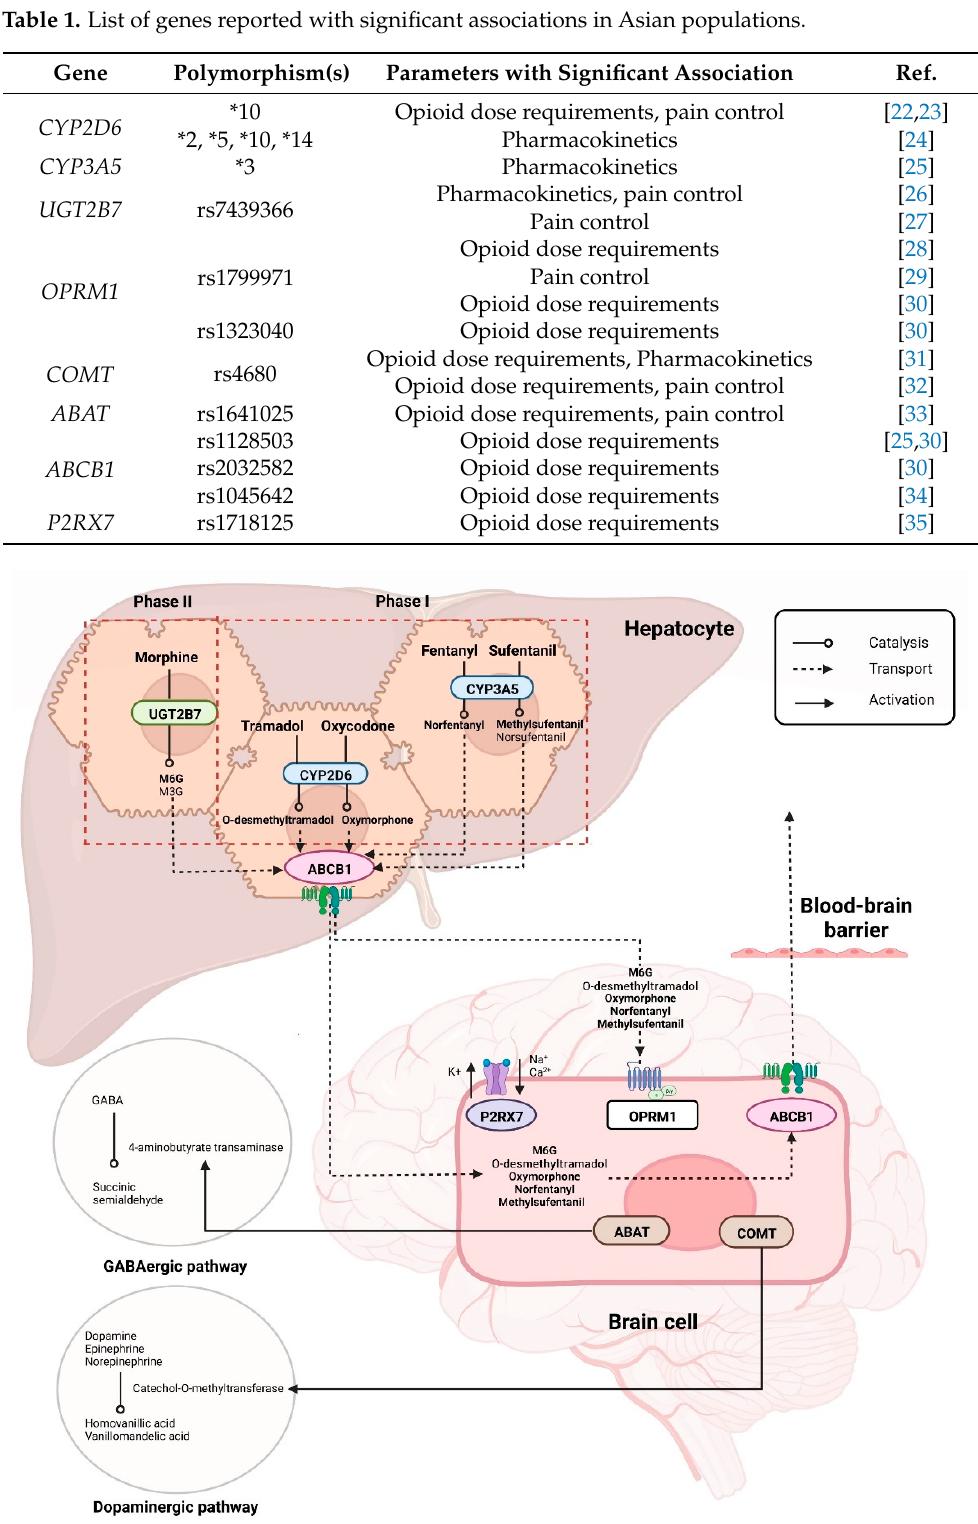
Figure 2. Pathways of genes that affect cancer pain treatment outcomes via drug-metabolizing en- zymes ( CYP2D6 , CYP3A5 , UGT2B7 ), opioid receptor ( OPRM1 ), pain modulation through GABAergic and dopaminergic pathways via neurotransmitter-metabolizing enzymes ( COMT , ABAT ), efflux drug transporters ( ABCB1 ) and cell depolarization via ion channels ( P2RX7 ). Created with BioRen- der.com.